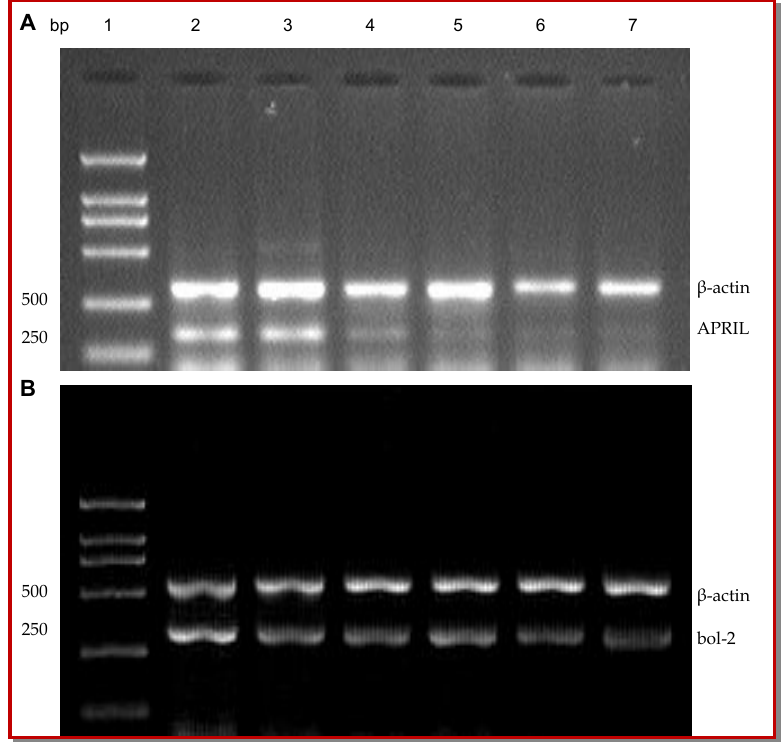
Figure 4: Expression of APRILmRNA (A), bcl-2Mrna (B) on HepG2 cells after treatment in different groups. 1: Marker DL2000; 2: Control; 3: ICA group; 4: BAI group; 5: ADM group; 6: ICA+ADM group; 7: BAI + ADM